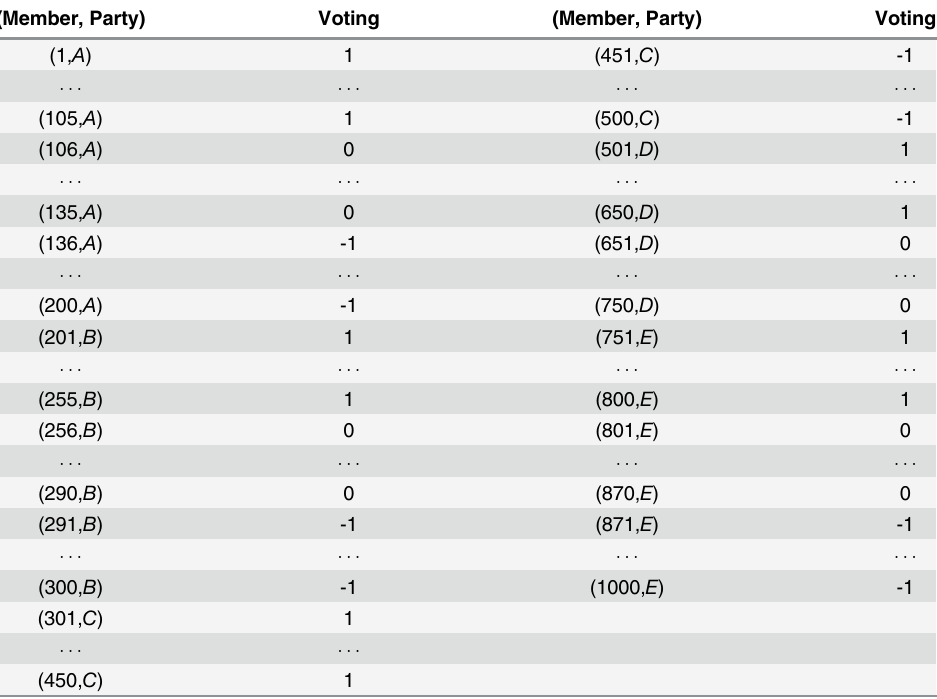
Table 2. Conflict situation with agents ( Member , Party ) and the voting function Voting.